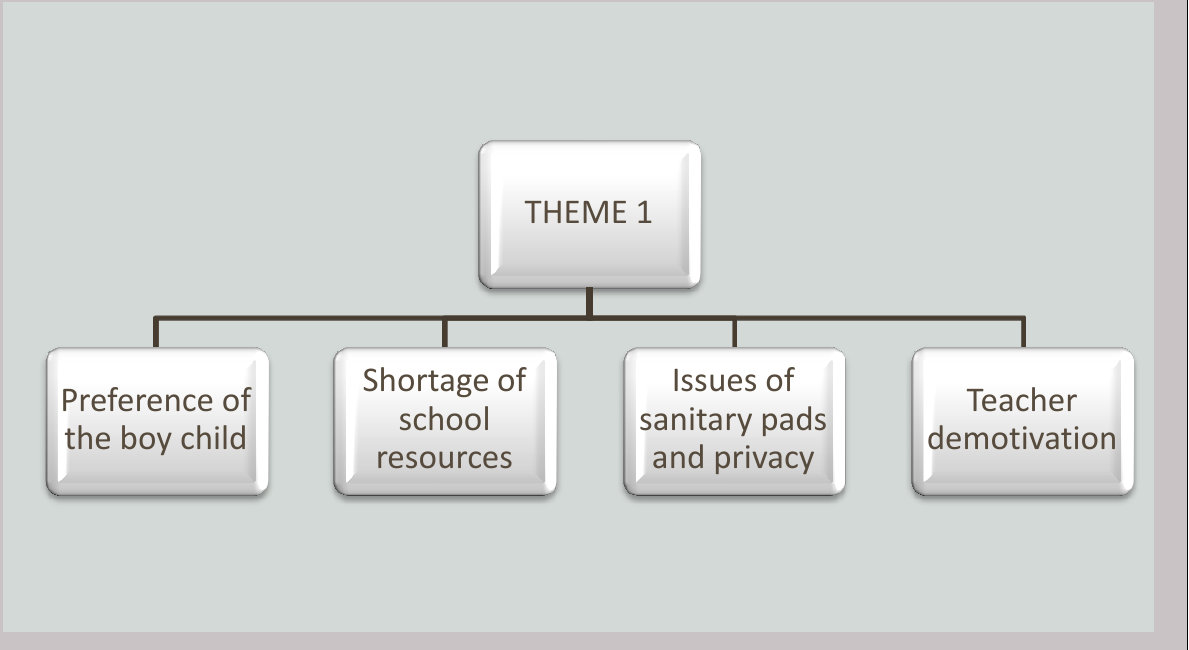
Figure 5.6: Sub-themes emerging from theme 1 (Field data,